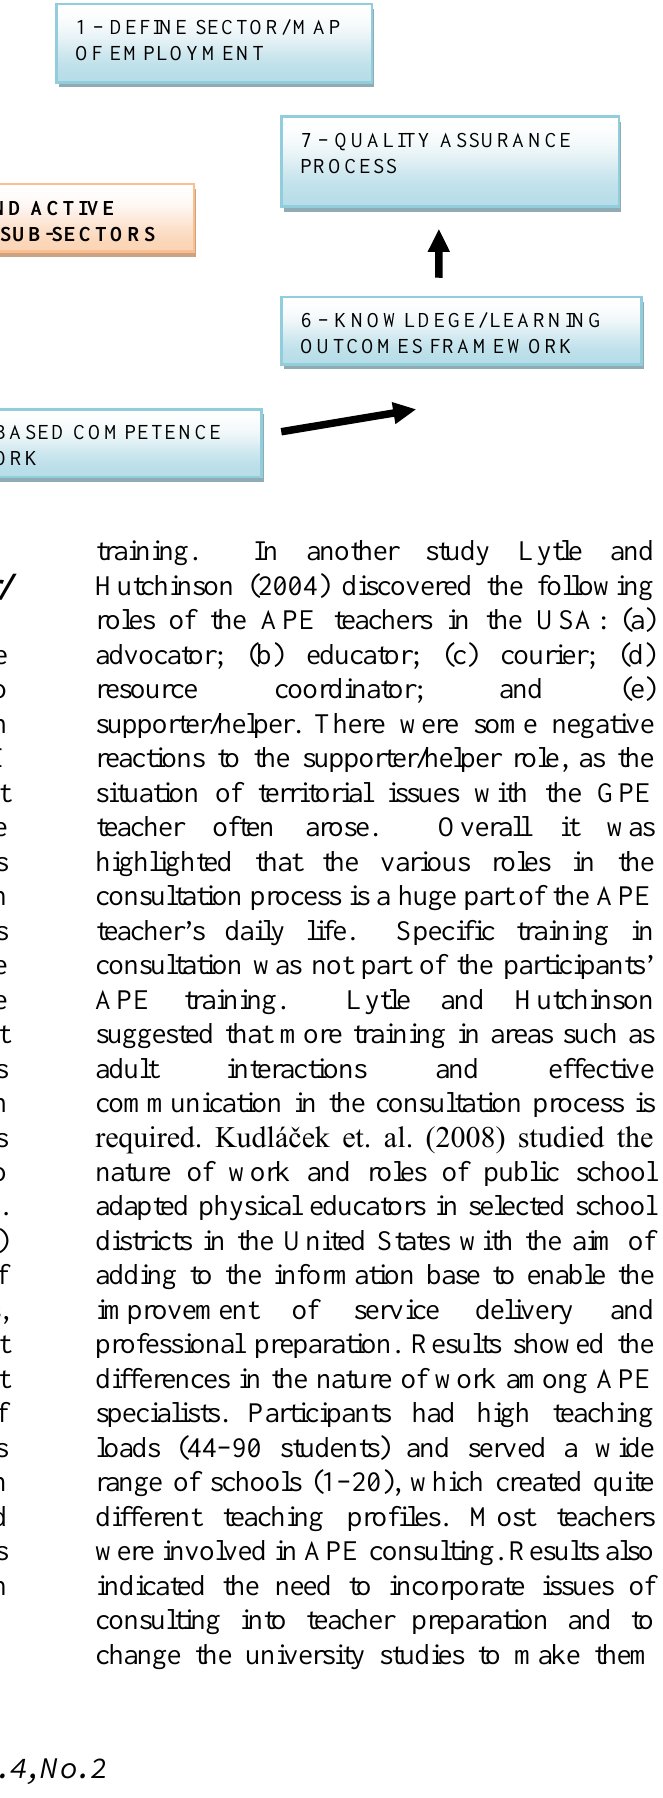
Figure 1 .The sport and active leisure sector qualification